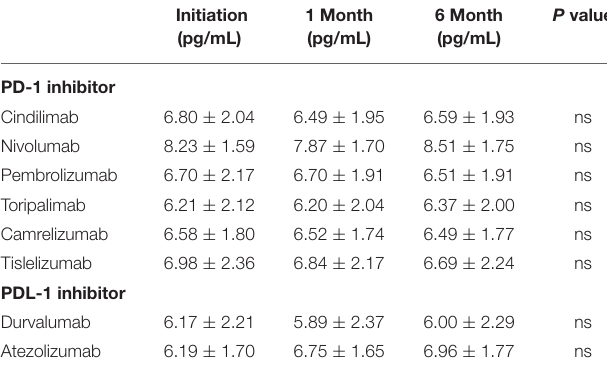
TABLE 3 | NT-proBNP levels among paients utilizing PD-1 or PDL-1